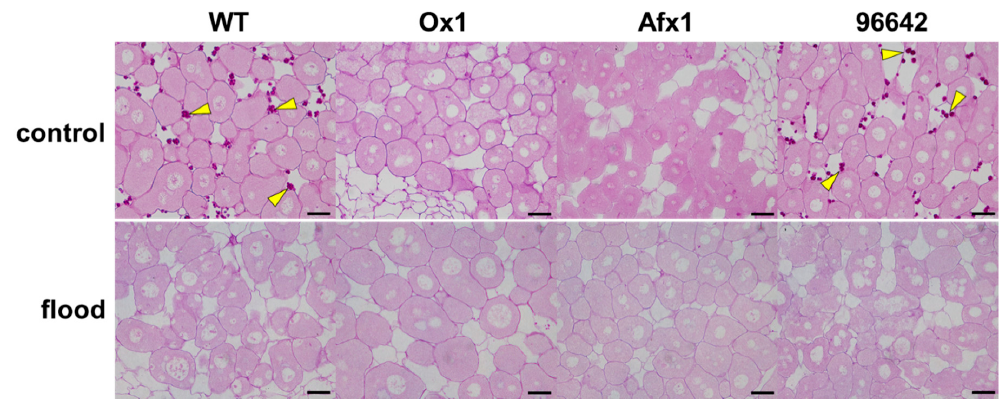
Figure 4. Microscopic images of nodules of WT, Ox1, Afx1, and 96642 plants. Sections of flooded or unflooded (control) nodules were stained with PAS to visualize infected cells and starch granules (arrowheads). Scale bars, 20 μ m.